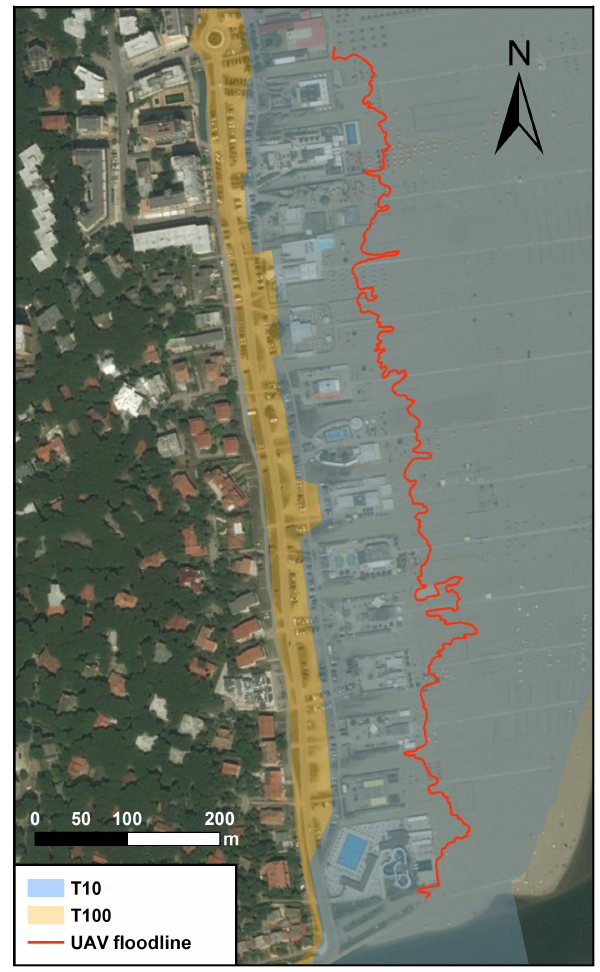
Figure 9. Comparisons between the observed UAV floodline and the flood scenarios (T10 and T100) computed by Perini et al.